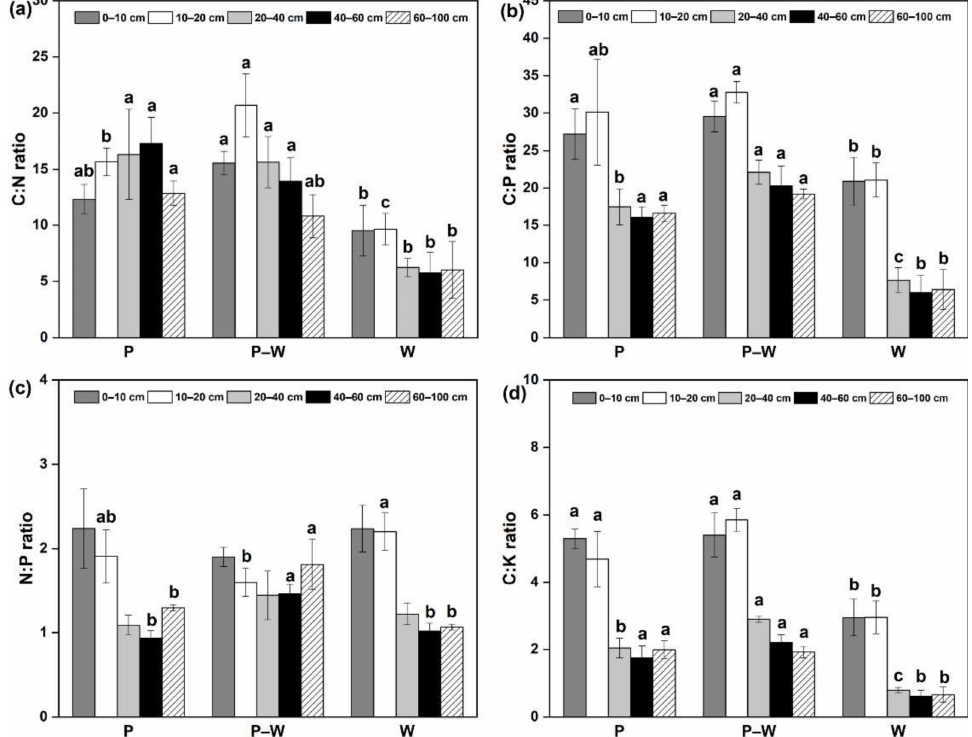
Figure 4. Vertical variation of the C:N ( a ), C:P ( b ), N:P ( c ) and C:K ( d ) ratios for the different land-use types. The different lowercase letters indicate significant differences among the three land-use types within the same soil layer based on Duncan’s multiple comparison test at p < 0.05. P, poplar plantation